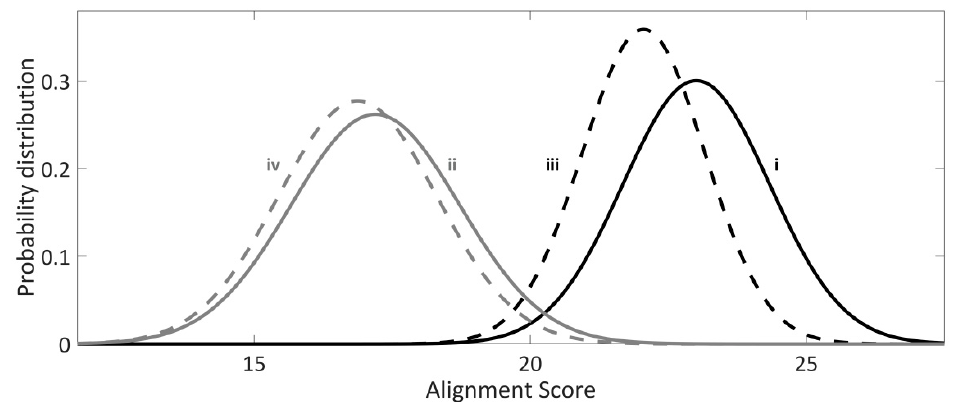
Figure 2. Normalized probability distributions of alignment scores for ( i ) E. coli genome - black solid curve, (ii ) the genomes of all sequenced E. coli infecting bacteriophages — gray solid curve, ( iii ) randomized E. coli genome background — dashed black curve, ( iv ) randomized bacteriophage genome background — dashed grey curve.